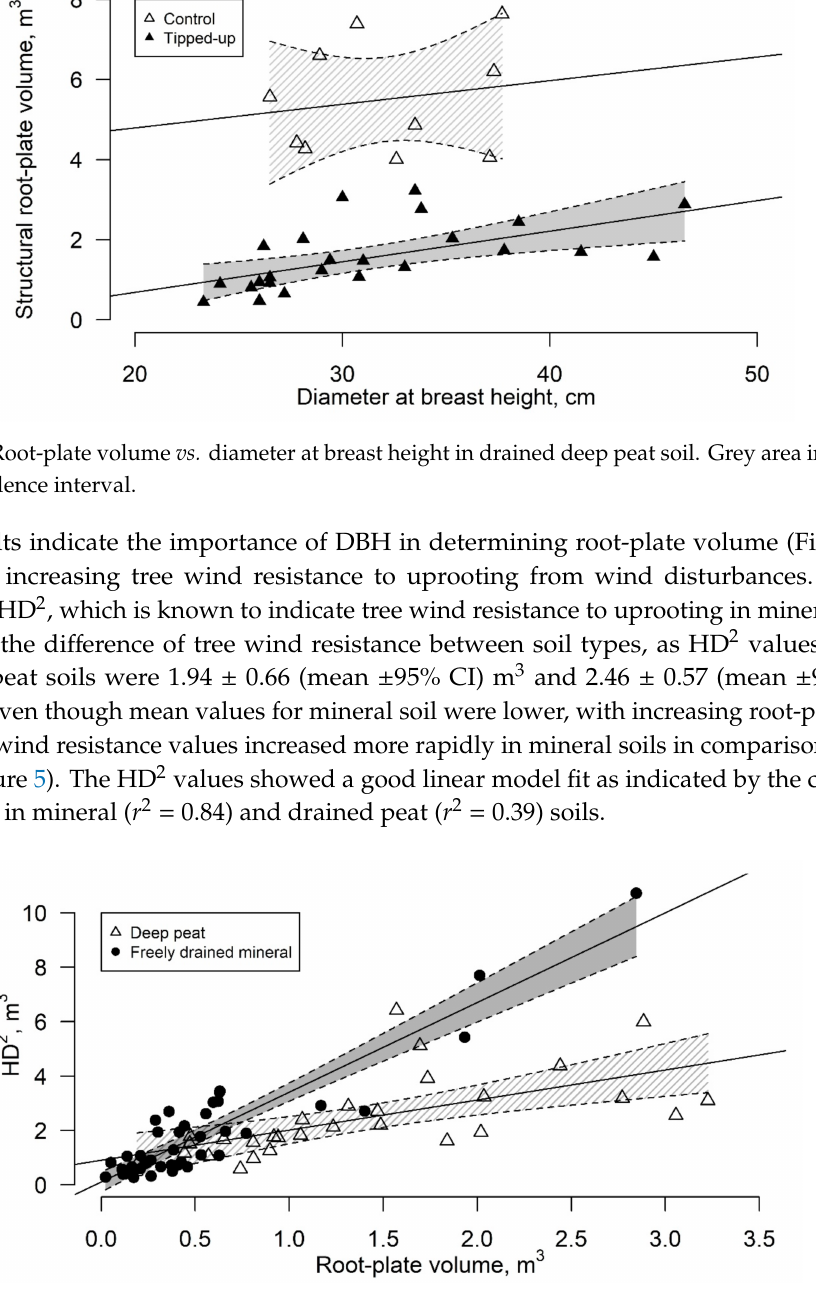
Figure 5. HD 2 inrelationtoroot-platevolumeintwosoiltypes.